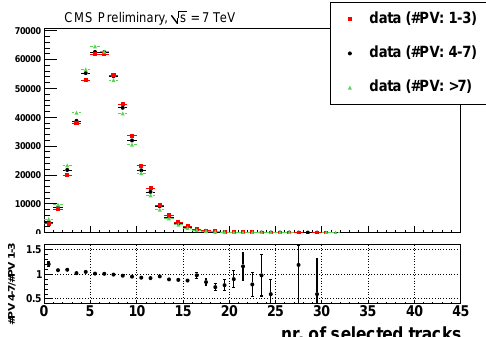
Fig. 2. Number of tracks associated to a jet after selection cuts.